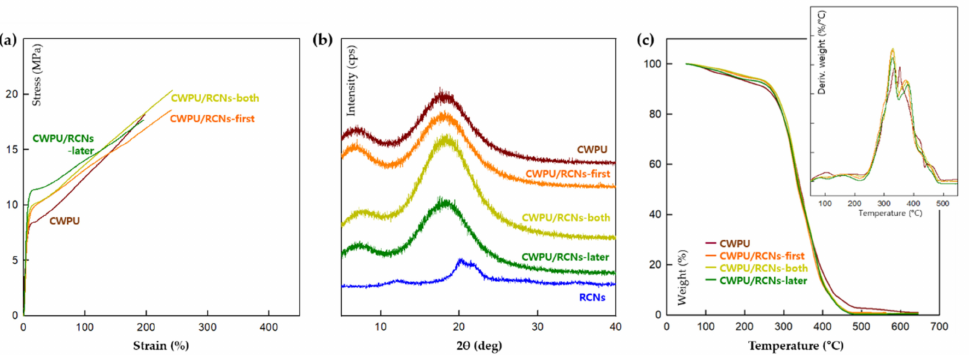
Figure 4. ( a ) Stress-strain curves, ( b ) XRD pattern, ( c ) TGA dynamic thermograms of CWPU and CWPU/RCNs nanocomposite films according to the step of adding